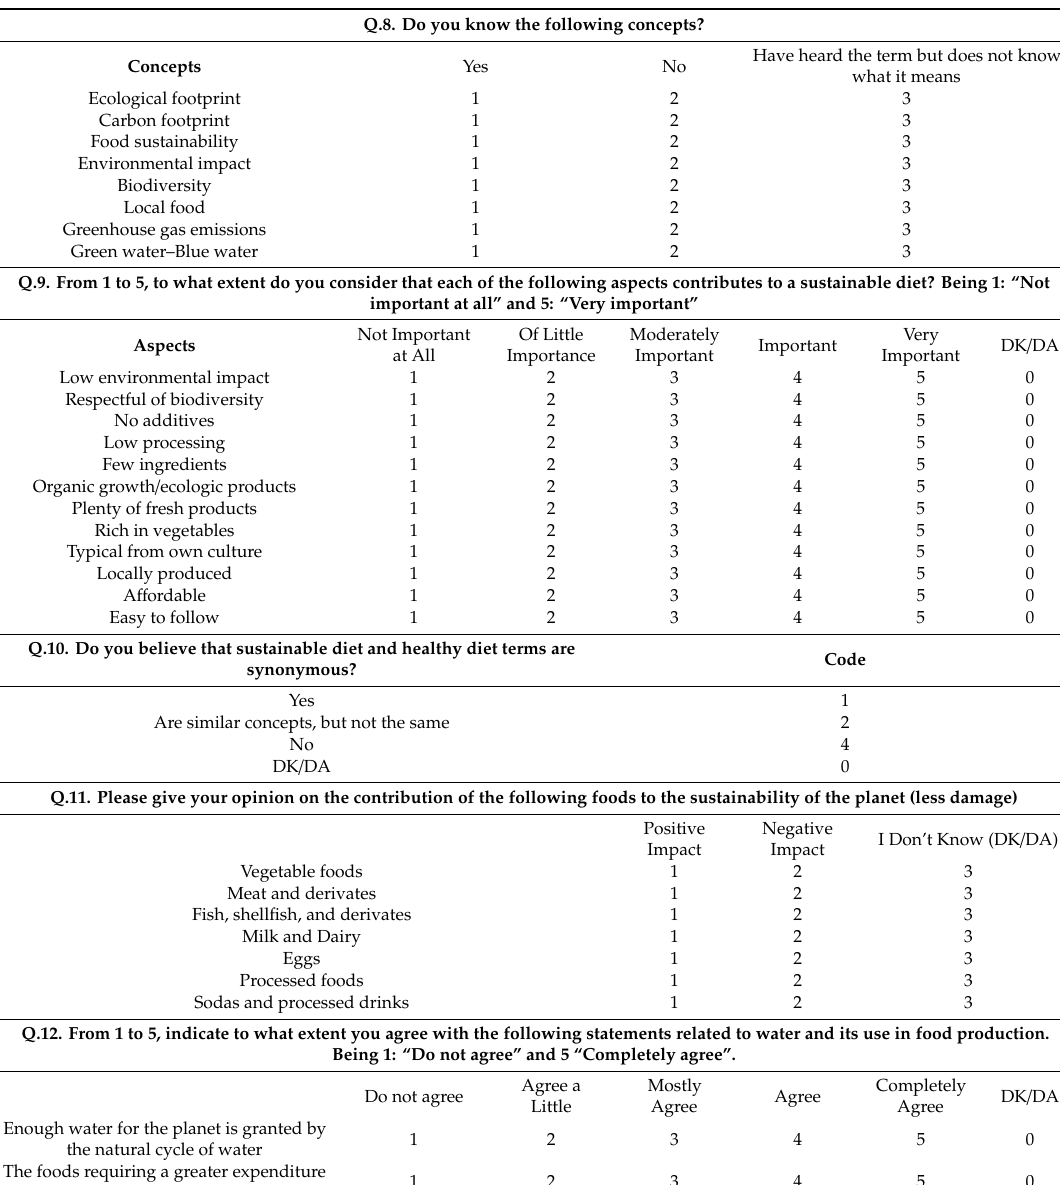
Table A2. Knowledge on Sustainability and Food